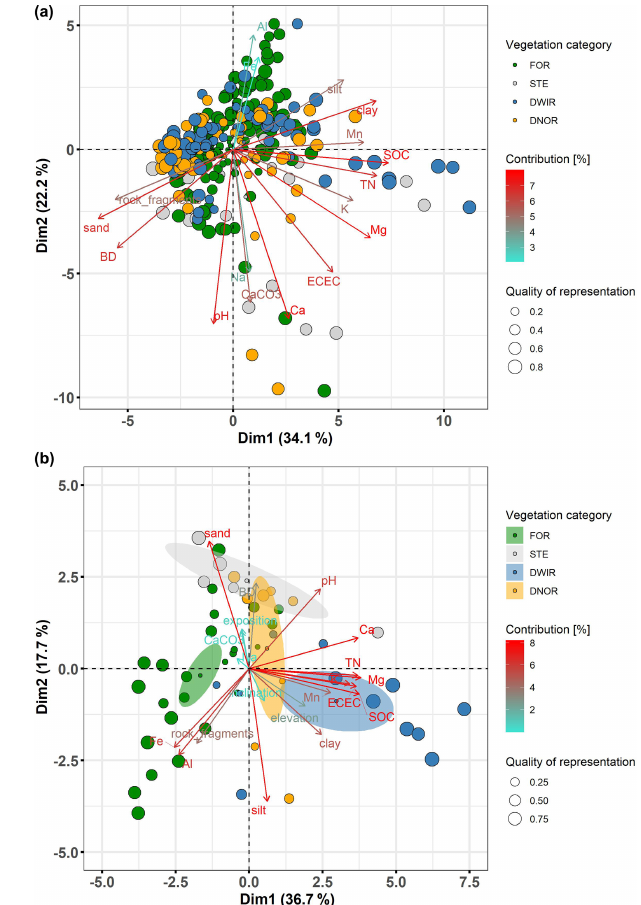
Figure 5. (a) PCA of the properties of the entire soil profiles under the following four vegetation categories ( n = 303): near-natural for- est (FOR; green), steppe close to the forest (STE; grey), disturbed forest with regrowth of trees (DWIR; blue), and disturbed forest showing no regrowth of trees (DNOR, orange). (b) PCA of the prop- erties of the uppermost 10cm of the soil profiles under the four veg- etation categories ( n = 52). In addition, inclination, exposition, and elevation were included in the second PCA. Arithmetic means and 95% confidence intervals of the data for soils under each vegetation category are represented by a smaller circle and a shaded ellipse, re- spectively. SOC is soil organic carbon, TN is total nitrogen, ECEC is effective cation exchange capacity, BD is bulk density, and Ca, Mg, K, Na, Al, Fe, and Mn are exchangeable cations.